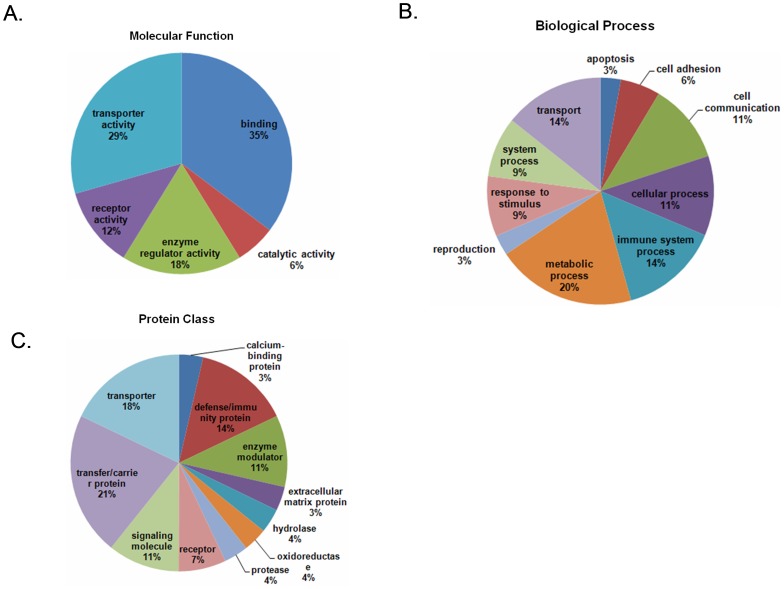
Functional classifications of the identified proteins according to their (A) molecular functions, (B) biological processes and (C) protein class by PANTHER.